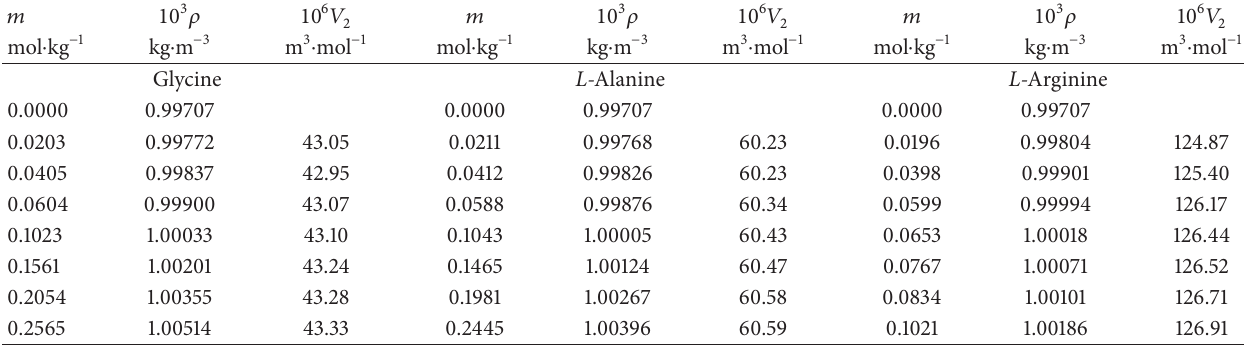
Table 1: Density, 𝜌 , and apparent molar volumes, 𝑉 2 , of amino acids in aqueous solutions as a function of amino acids concentration, 𝑚 , at T = 298.15 K.